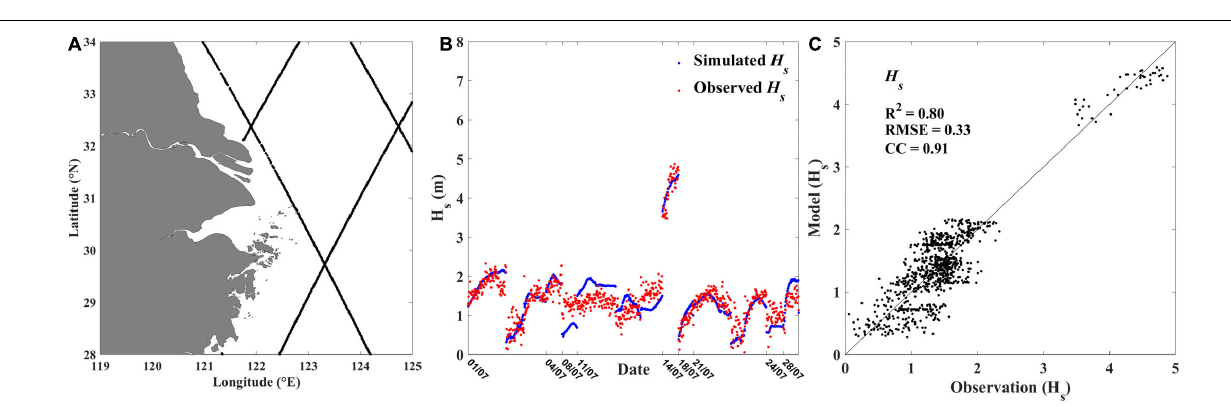
FIGURE 4 | (A) The distribution of observation points along the satellite orbit over the East China Sea during July 2006. (B,C) The comparison between the observed and simulated significant wave height ( H s